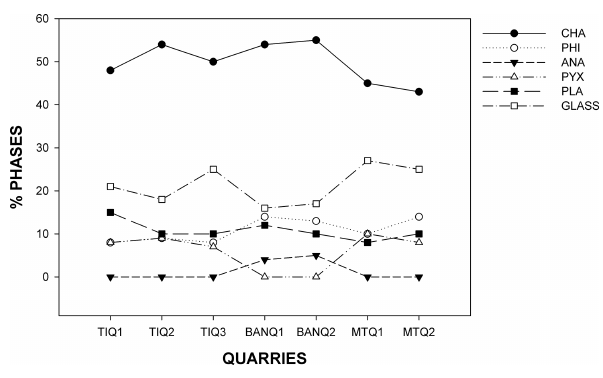
Figure 2. Weight percent variation in main mineralogical phases (calculated with the QPA Rietveld and RIR method) for the three quarries. CHA: chabazite; PHI: phillipsite; ANA: analcime; PYX: pyroxene; PLA: plagioclase.